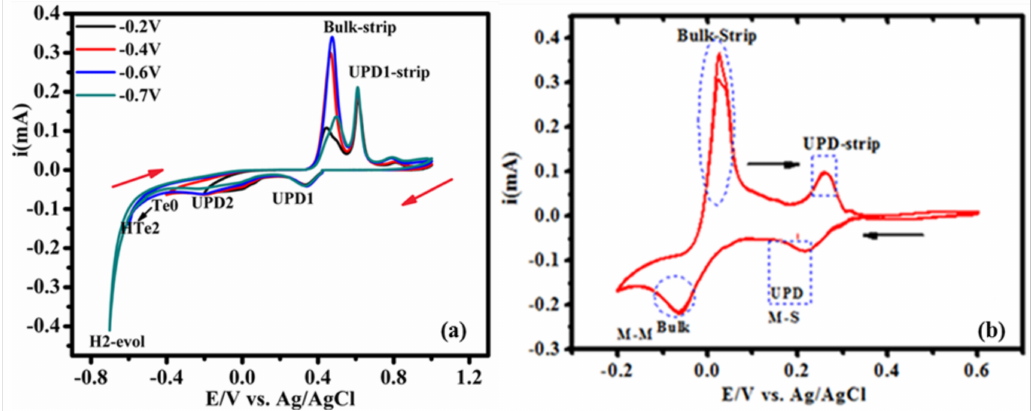
Figure 1. CV of Au recorded in aqueous solutions containing ( a ) 0.5 mM HTeO + 2 + 0.1 M HClO 4 and the profiles recorded in ( b ) 1 mM CuSO 4 + 0.1 M HClO 4